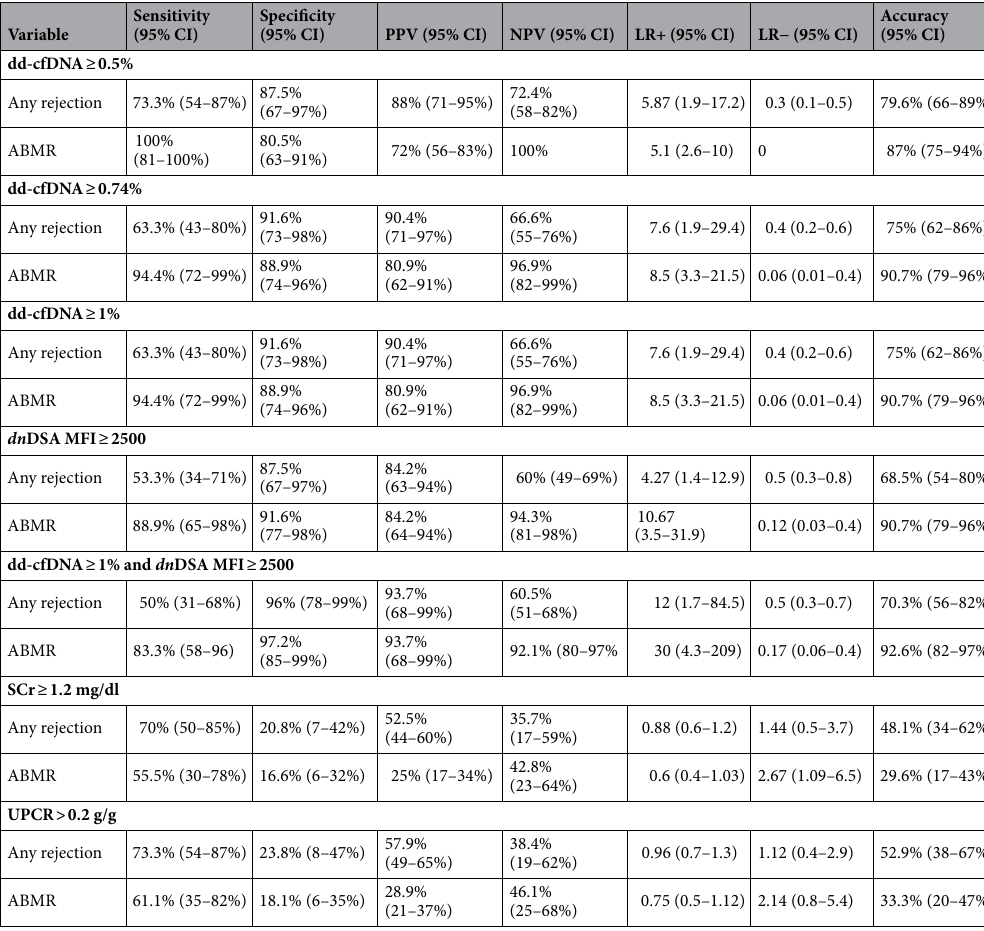
Table 4. Performance characteristics of clinical variables to discriminate any rejection and antibody-mediated rejection. dd-cfDNA, donor-derived cell-free DNA; dn DSA, de novo donor-specific antibody; ABMR, antibody-mediated rejection; PPV, positive-predictive value; NPV, negative predictive value; UPCR, urine protein:creatinine ratio; SCr, serum creatinine; LR+, positive likelihood ratio; LR−, negative likelihood ratio; CI, confidence